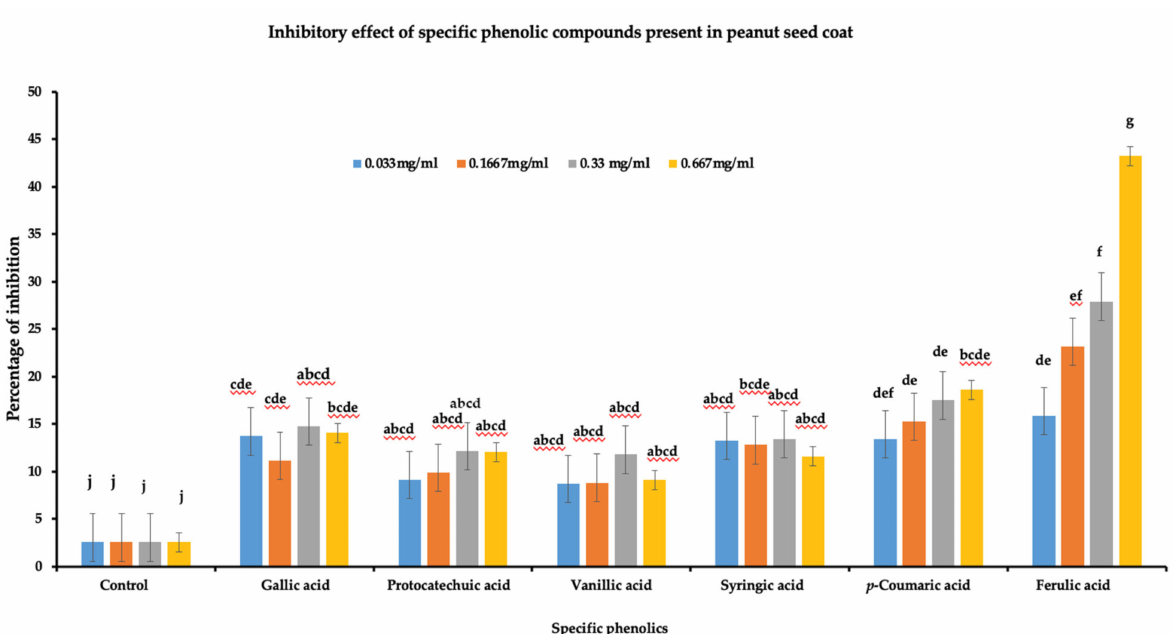
Figure 5. Inhibitory effect of phenolic acids against A. flavus growth. Six individual phenolics were dissolved in DMSO at four different concentrations (0.667 mg/mL, 0.33 mg/mL, 0.1667 mg/mL, and 0.033 mg/mL). Individual phenolic acids dissolved in DMSO were added to PDA media along with control DMSO, and plates were inoculated with 10 µ L of A. flavus spores (1 × 10 7 CFU mL − 1 ). The Petri plate was incubated at 28 ◦ C, daily radial growth was measured for seven days, and the data were used to calculate the percentage of inhibition (3 biological replicates). One-way ANOVA was used to determine the significant difference between different groups. Means not sharing the same letter are significantly different ( p < 0.05), and the error bar represents the standard error ( n =